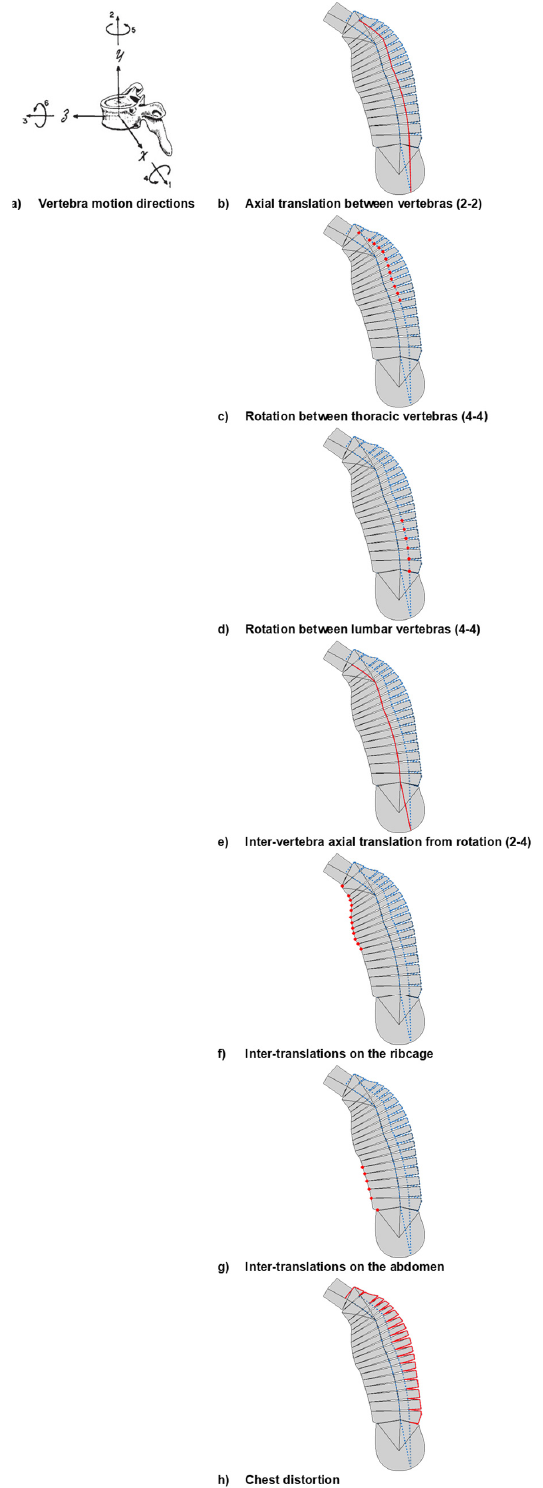
Figure 7. Kinematic restraints for the chest.